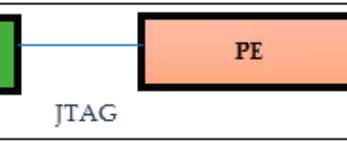
Figure 5. Environmental setup of emulator.